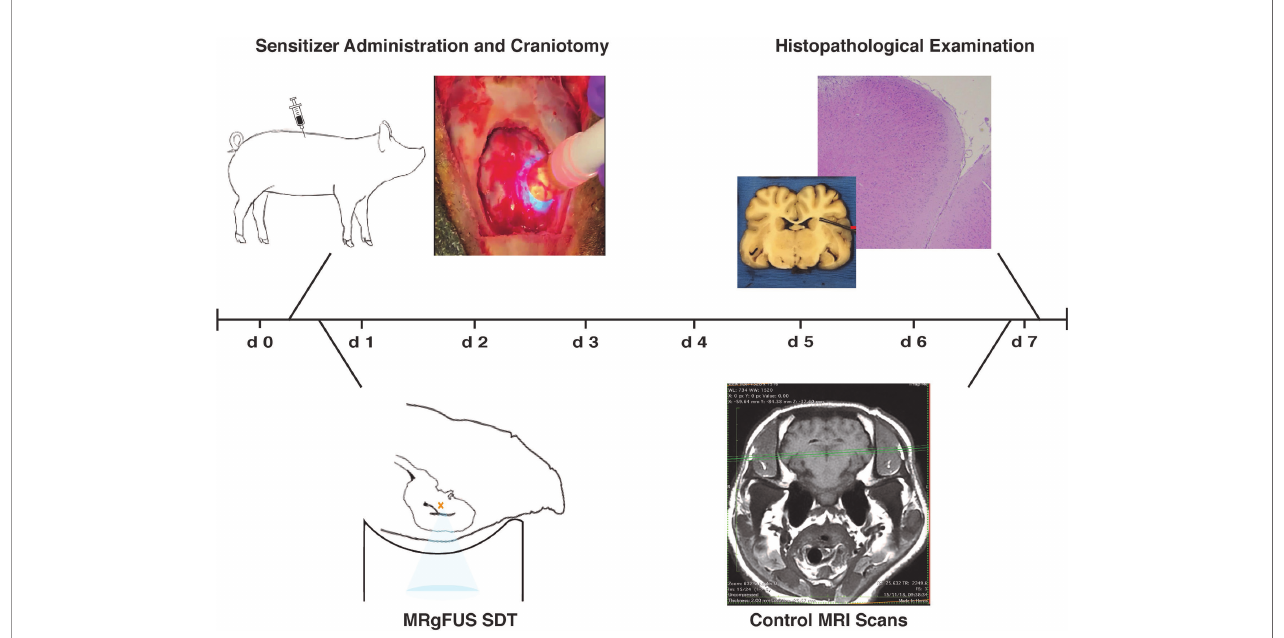
FIGURE 1 | Timeline of experimental treatments. Subjects were administered the assigned sensitizing compound right before undergoing craniotomy at day one. After the procedure, subjects were placed in prone position inside the Exablate device and received MRI-guided low-intensity insonation. On the day 3, MRI scans were acquired again to be later compared with pre-treatment tracking images. Upon sacri fi ce on the seventh day, brains were harvested for histopathological